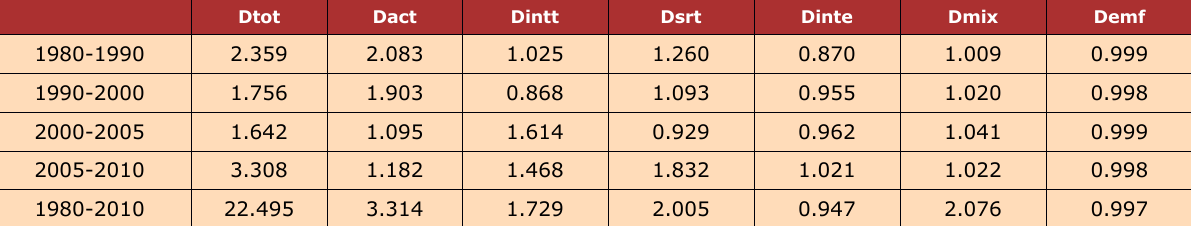
Table 3. Multiplication decomposition of CO 2 emission in logistics industry